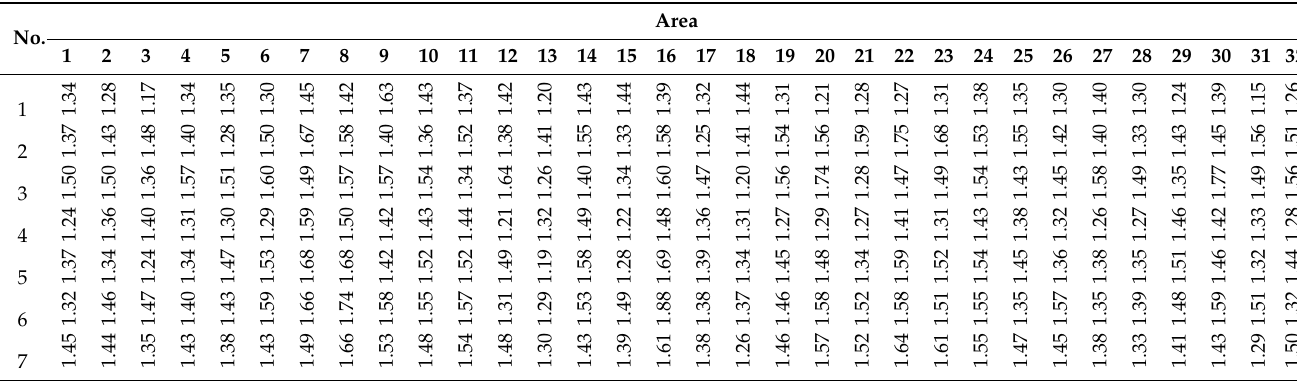
Table 6. Standard deviations of the responses given in the